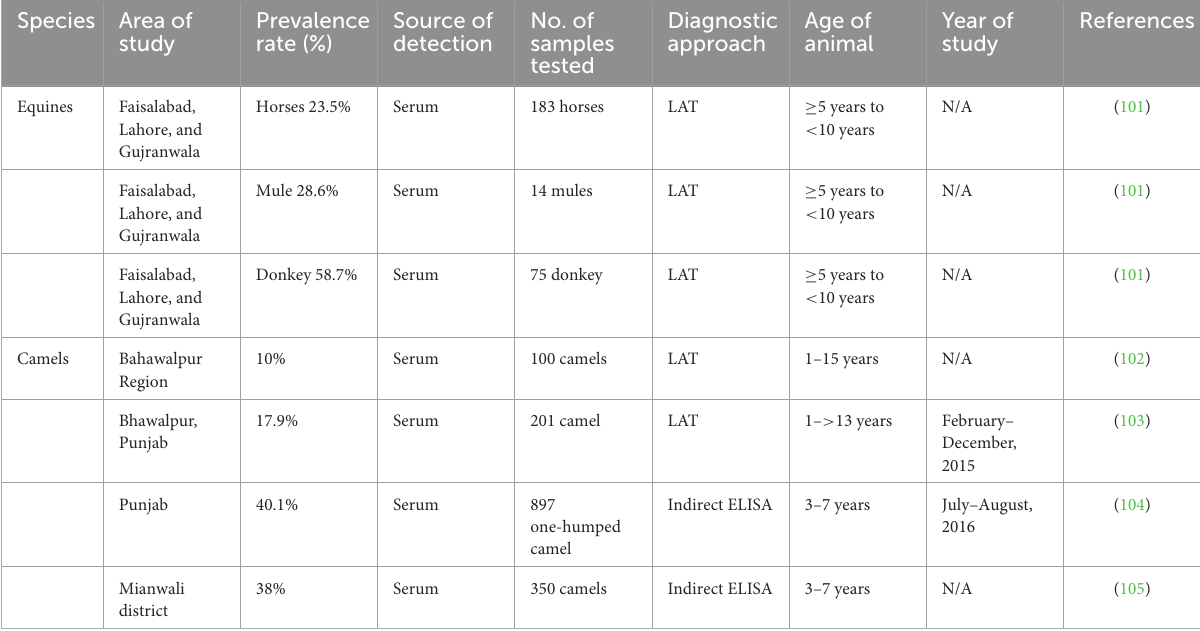
TABLE 5 Reported prevalence of Toxoplasma gondii in equines and camels of Pakistan. Species Area of study